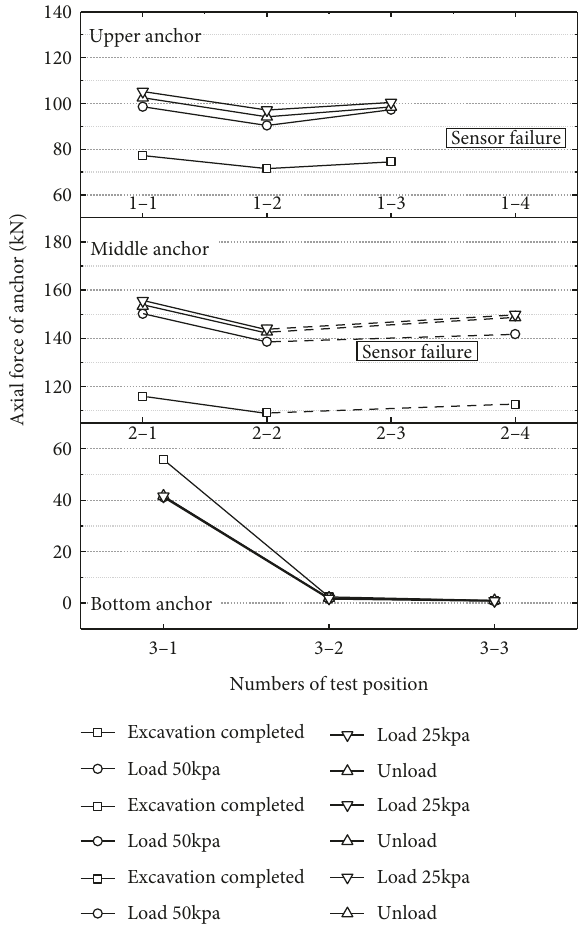
Figure 13: Axial force distribution of each row of anchor rod body before and after